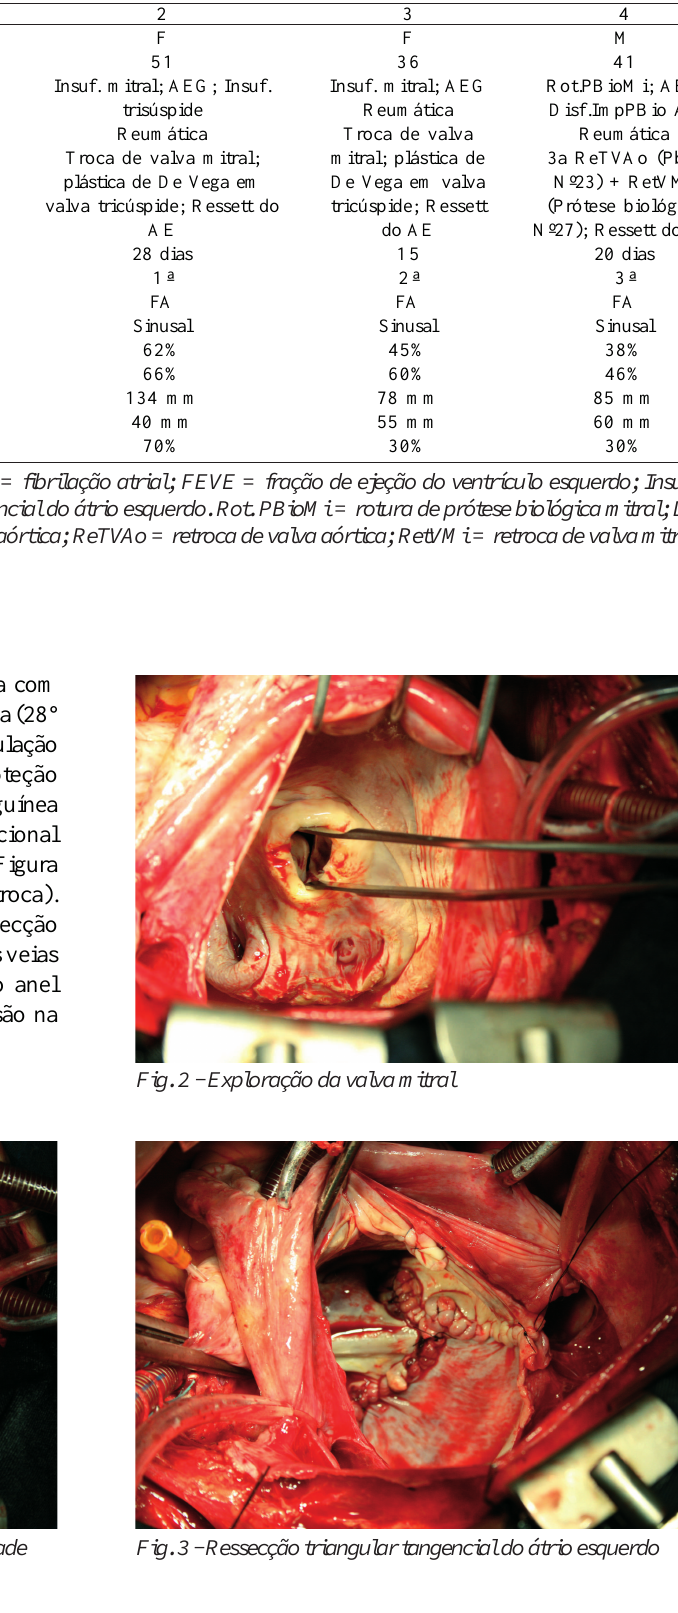
Tabela 1. Dados cirúrgicos.